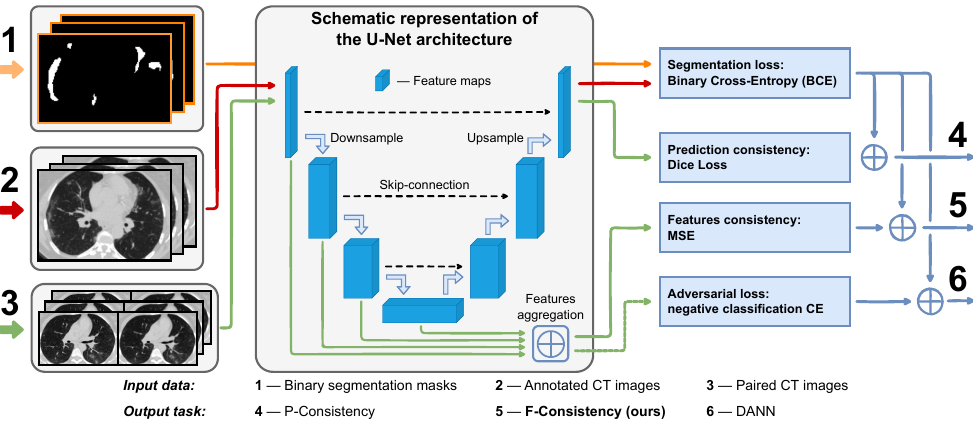
Figure 1. Schematic representation of the proposed method, F-Consistency ( 5 ), and its competitors, P-Consistency ( 4 ) and DANN ( 6 ). All methods build upon the same U-Net architecture, which we train to segment the COVID-19 binary mask ( 1 ) from the axial slices of chest CT images ( 2 ). These adaptation methods use unlabeled paired data ( 3 ) to improve the model performance on the target domain. We show the flow and different usage of the paired data in different methods with